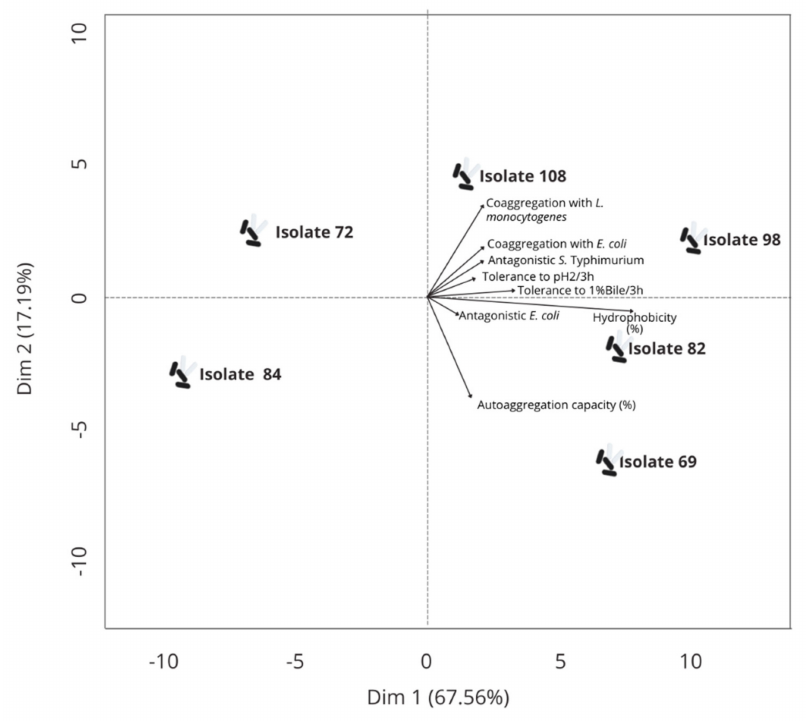
Figure 1. Principal component analysis (PCA) run for lactic acid bacteria isolates from xique- xique cladodes and fruit showing the variable projection to acid tolerance, survival with bile salts, hydrophobicity, auto-aggregation, coaggregation capacity, and antagonist